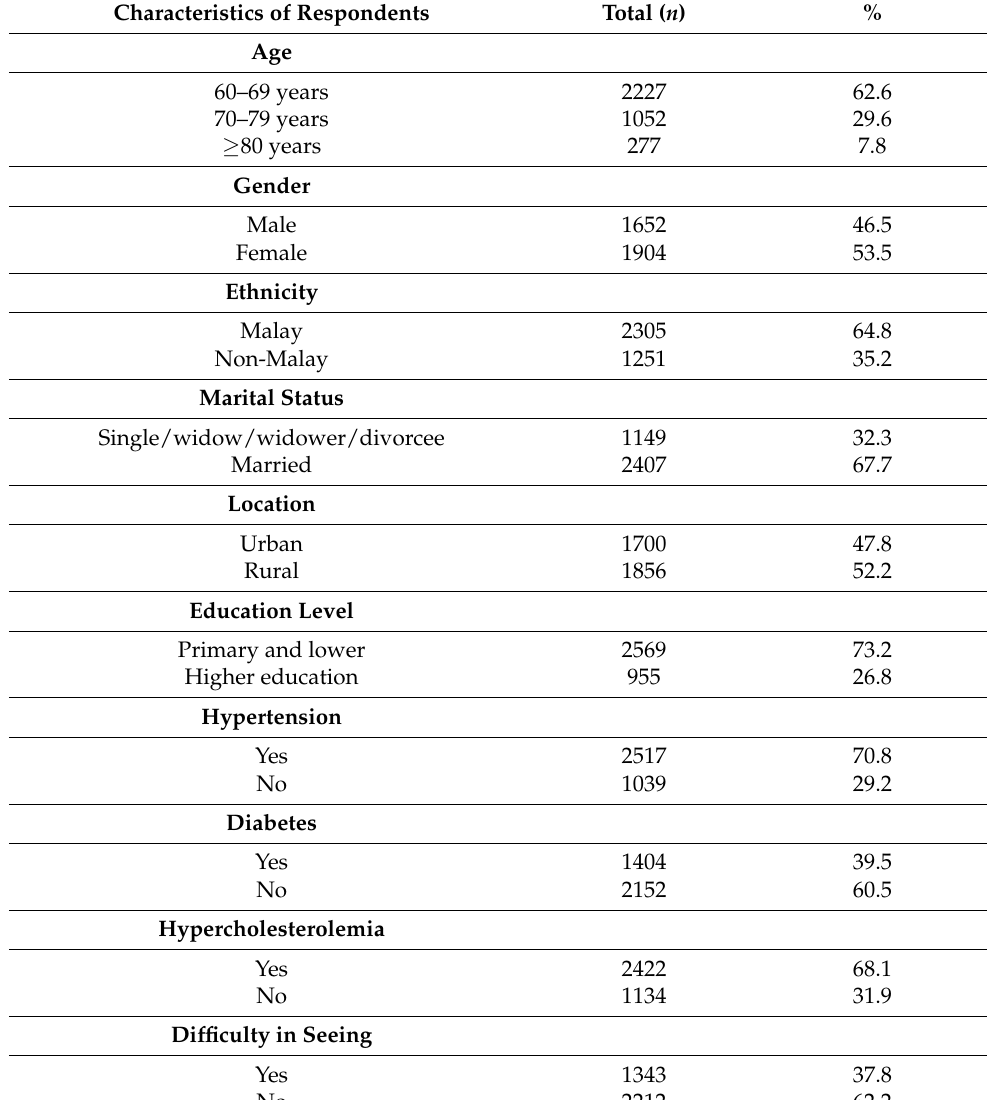
Table 1. Background characteristics of the study participants (N = 3556). Characteristics of